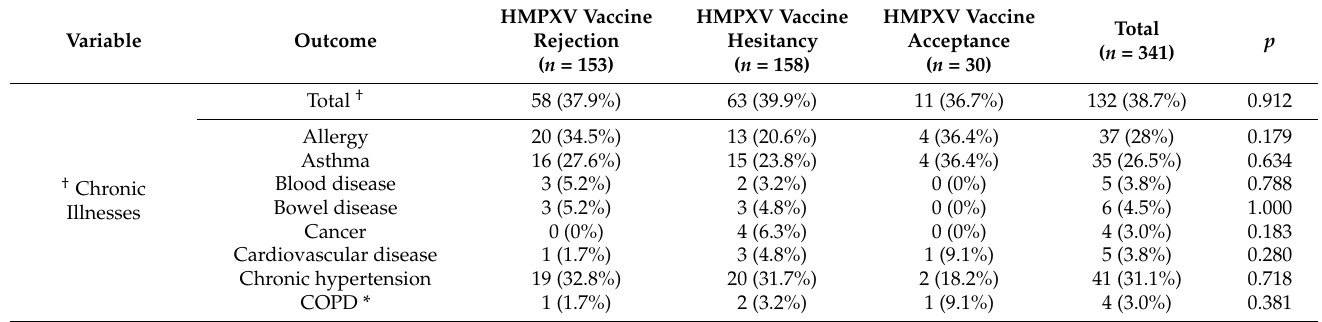
Table 2. Anamnestic characteristics of Czech HCWs responding to the HMPXV survey, September 2022 ( n = 341).